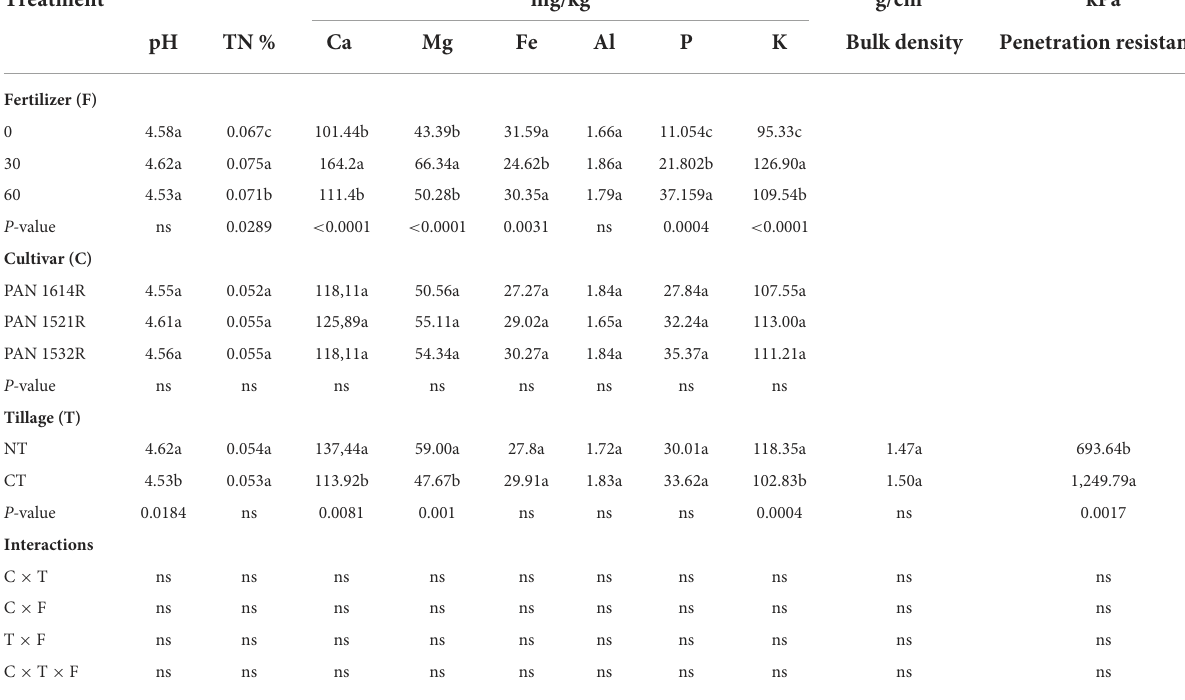
TABLE 2 Effects of fertilizer, cultivar and tillage on soil physico-chemical properties on a soybean cropping system. Treatment